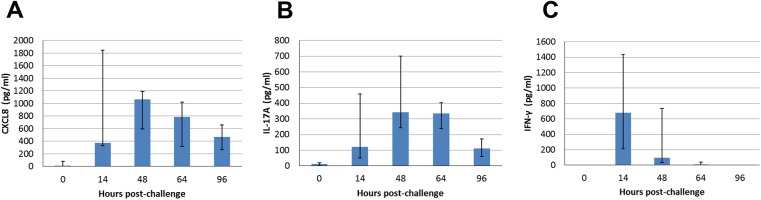
Concentrations of cytokines in milk samples of the 10 responder cows.Time-course of concentration variation (median and interquartiles) of CXCL8 (A), IL-17A (B) and IFN- γ (C) in the milk of quarters infused with ovalbumin at 0 hpi.